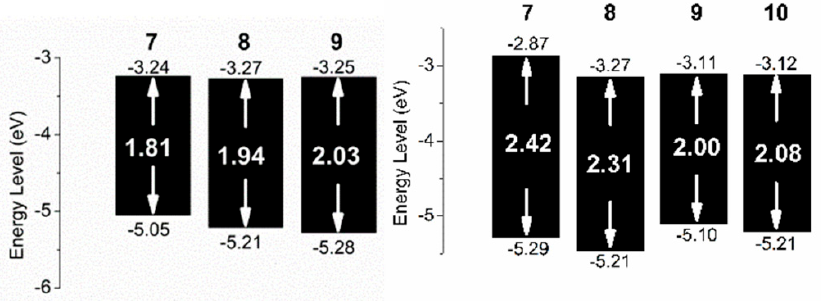
Figure 4. HOMO-LUMO energy levels for oligomers 7 – 9 as calculated by cyclic voltammetry (CV) in solution (left) and in the solid state (right).